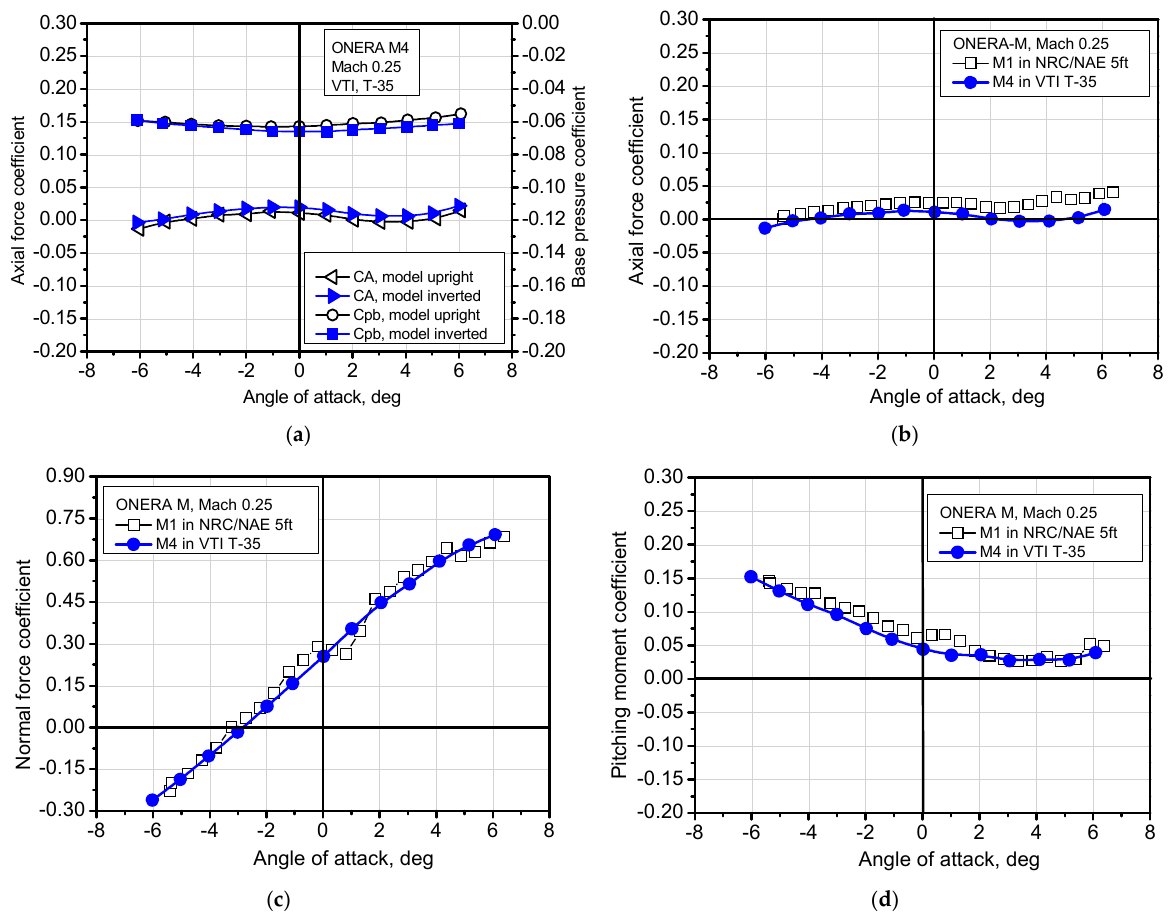
Figure 10. Wind tunnel test data; ONERA − M model, Mach 0.25; ( a ) symmetry check in VTI; ( b ) inter-facility comparison in axial force coefficient; ( c ) inter-facility comparison in normal force coefficient; ( b ) inter-facility comparison in pitching moment coefficient [37].